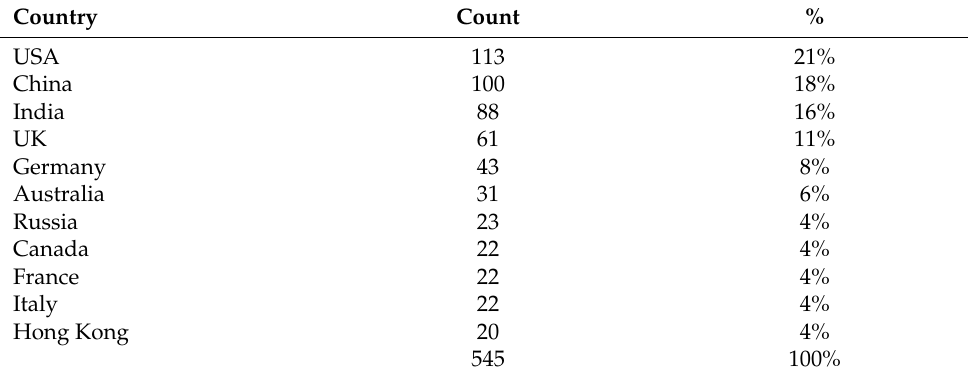
Table 5. Top ten countries according to the number of